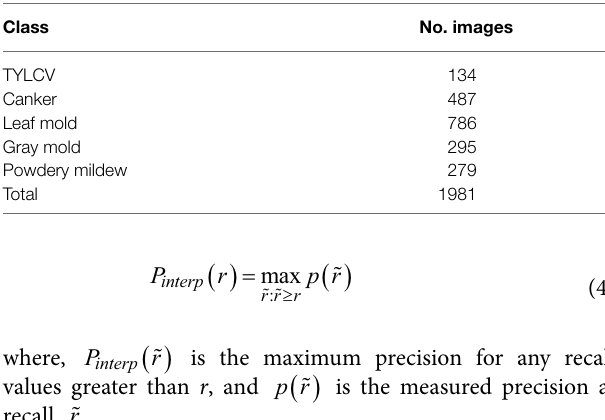
TABLE 2 | Inference dataset of target